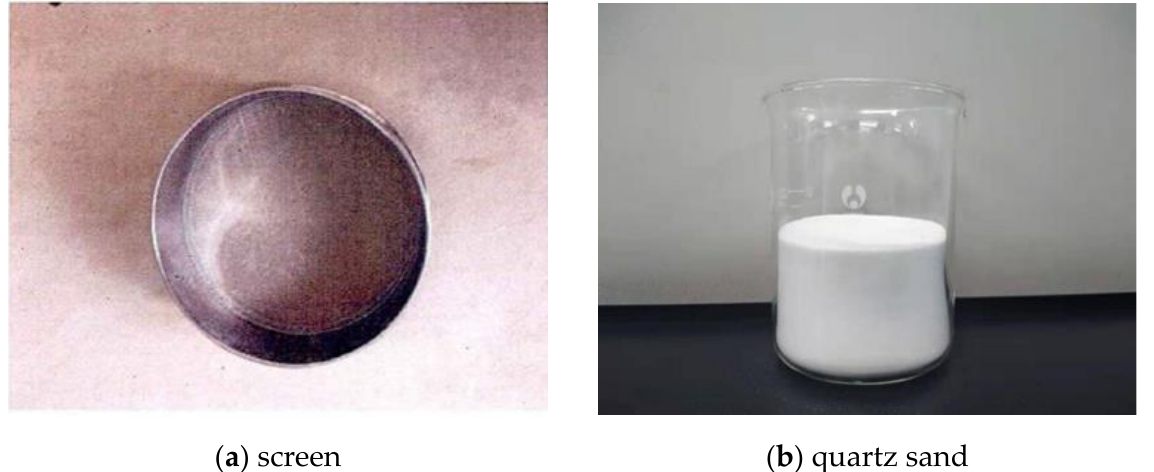
Figure 3. Screen and quartz sand used in the experiment.